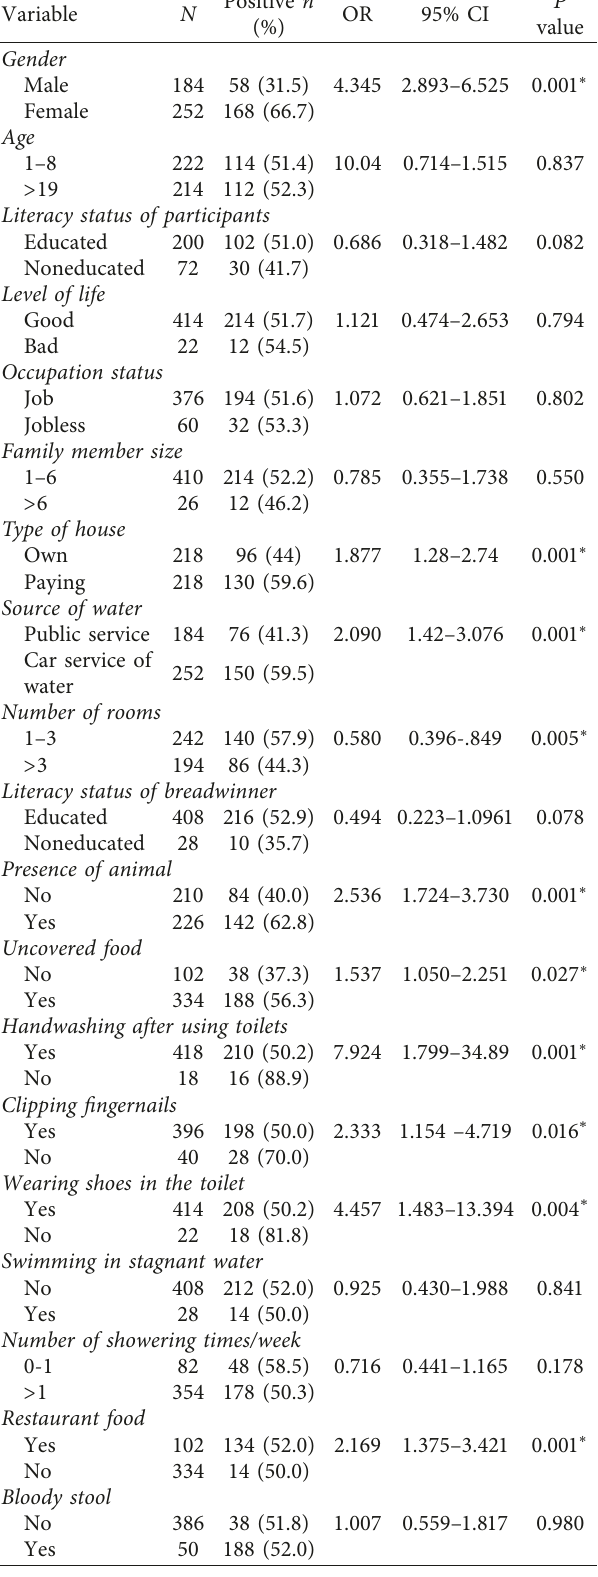
Table 3: The prevalence of intestinal parasites according to the socioeconomic data, environmental factors, symptoms, behaviors, and epidemiological factors